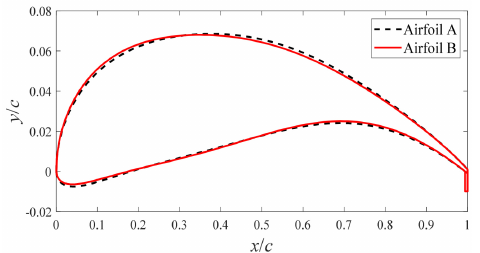
Figure 30. Geometries of the cross-sectional airfoils on Prop A and Prop B at 0.75